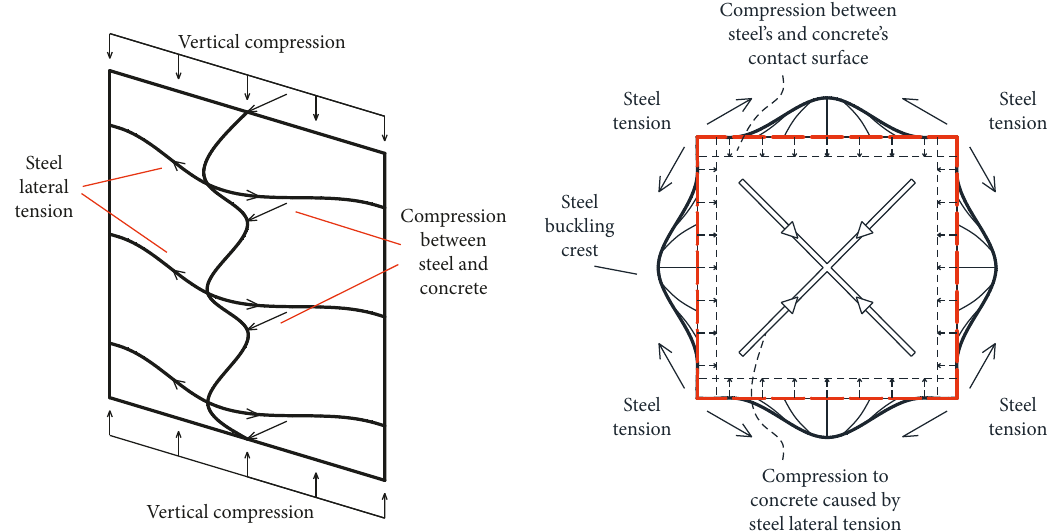
Figure 9: Interaction between concrete and steel.